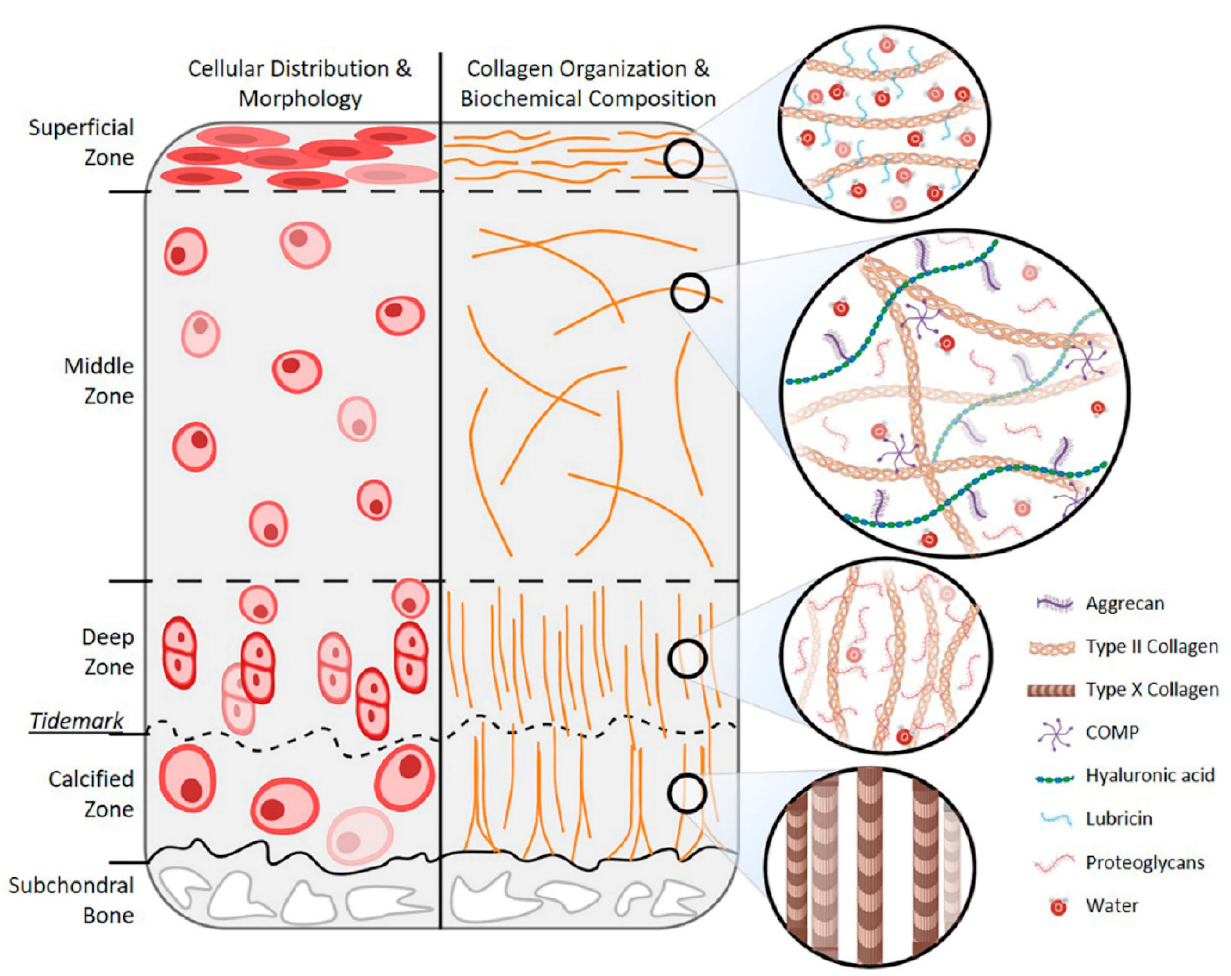
Figure 1. Schematic representation of the articular cartilage structure and biochemical composition [15].